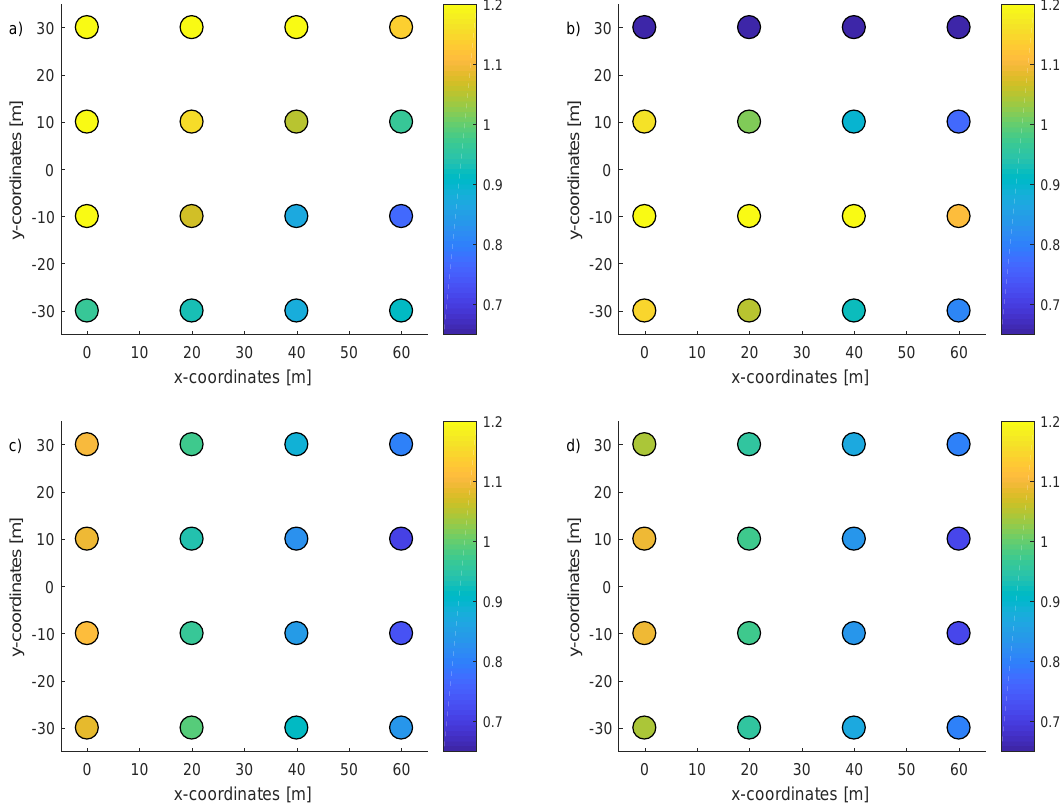
Figure 7. Time averaged energy absorption in a park consisting of 16 Wind Energy Conversion Systems (WECs.) The absorbed energy is divided by the absorbed energy of a single WEC in isolation to give the normalized energy absorption of Equation (8); hence, a value above 1 shows that the device absorbs more energy than an isolated device at the origin would, whereas a value below 1 shows that the absorption decreases. All short-crested wave simulations are run with 15 wave directions and spreading parameter s = 5. ( a , b ) two simulations in short-crested waves with different random phases; ( c ) average over 50 runs of short-crested waves with different random phases; ( d ) park in long-crested waves propagating along the x